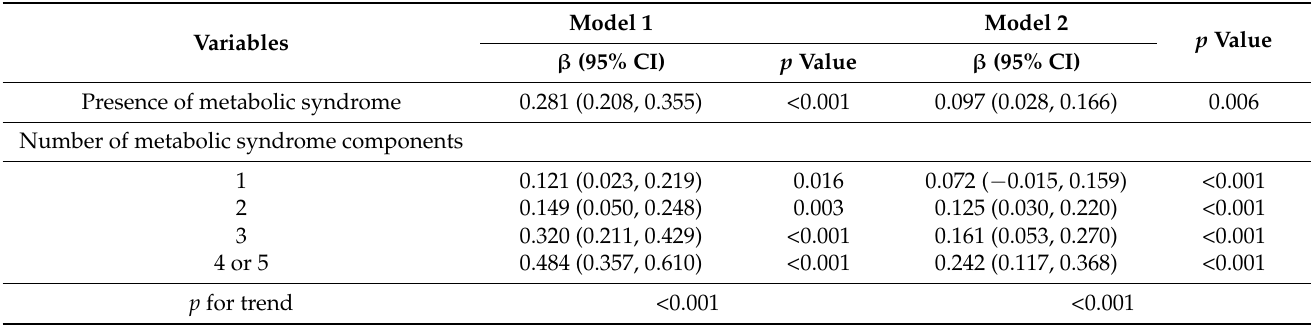
Table 2. Regression coefficients of the presence and number of metabolic syndrome components for human epididymal protein 4